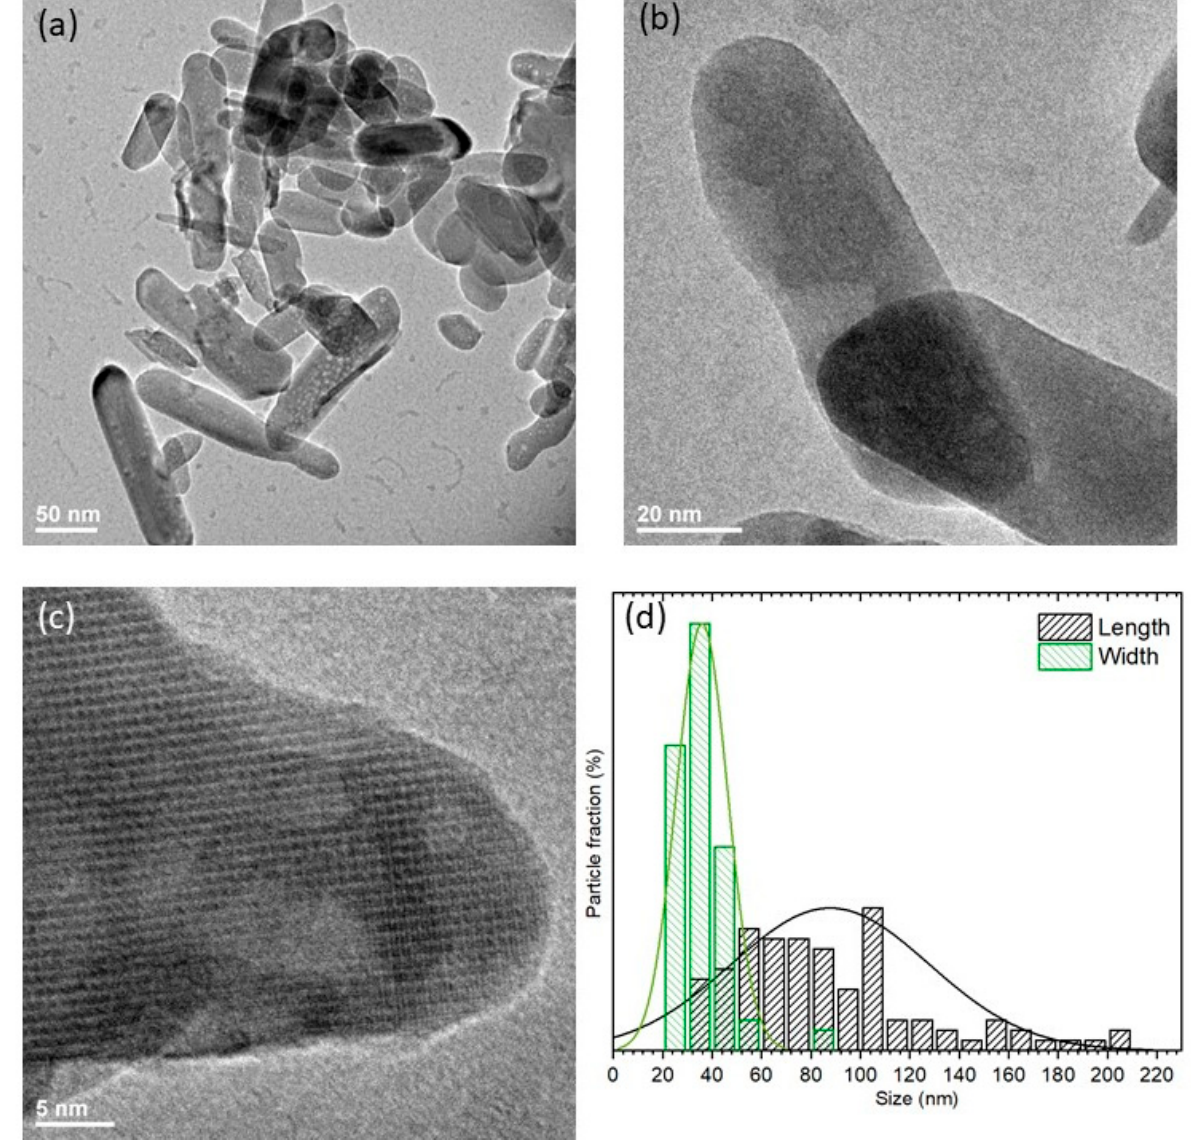
Figure 3. Representative TEM images ( a – c ) and particle size distribution ( d ) of the 1 mol% Eu 3+ :Ca 10 (PO 4 ) 6 (OH) 2 . The infrared spectra of the copper-doped, europium-doped, and co-doped hydroxyap- atite materials are presented in Figure 4. The most intense peaks are the triply degenerated antisymmetric stretching bands of phosphate groups ν 3 (PO 43 − ) located at 1044.5 cm − 1 and 1097.8 cm − 1 . The peaks observed at 566.0 cm − 1 and 603.1 cm − 1 correspond to the triply degenerated ν 4 (PO 4 3 − ) vibrations. The peaks at 963.0 cm − 1 are assigned to the non-degenerated symmetric stretching ν 1 (PO 43 − ) band. Two peaks corresponding to OH − group at 3571.5 cm − 1 and 633.5 cm − 1 are observed on the infrared spectra. The existence of these peaks clearly confirms the hydroxyapatite structure with a hydroxyl group in the host lattice. The broad bands between 3690 and 3290 cm − 1 were connected with H 2 O